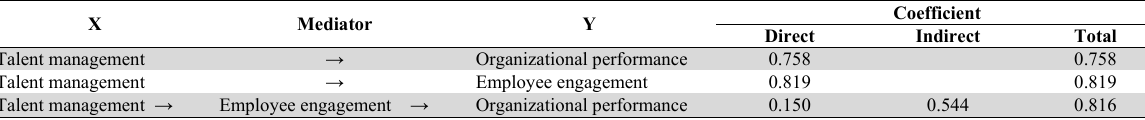
The summary of testing the